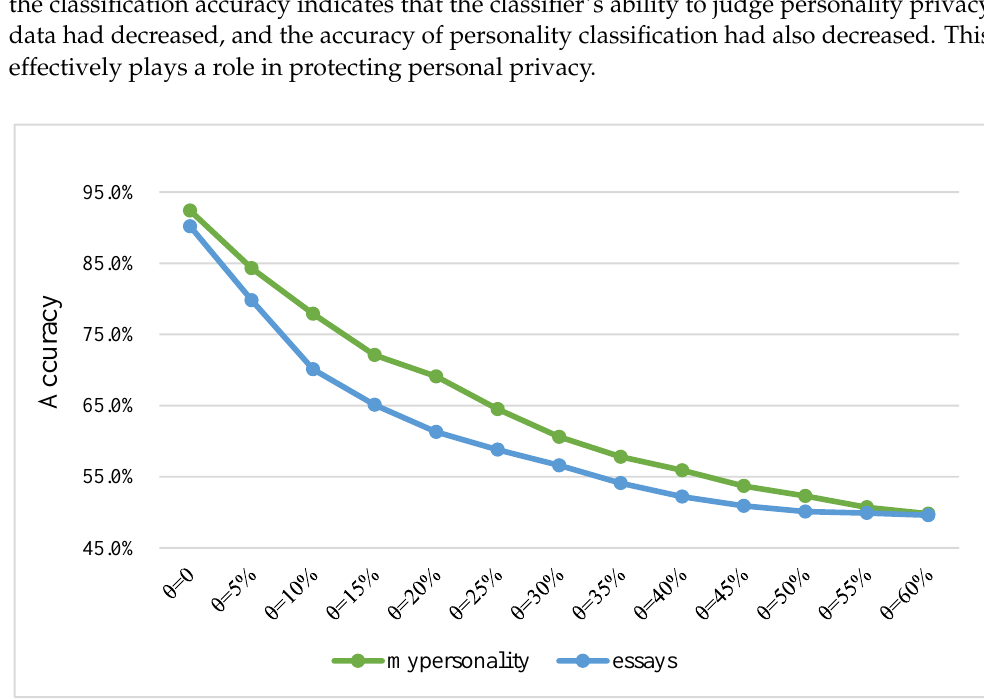
Figure 2. Experimental results of attack.